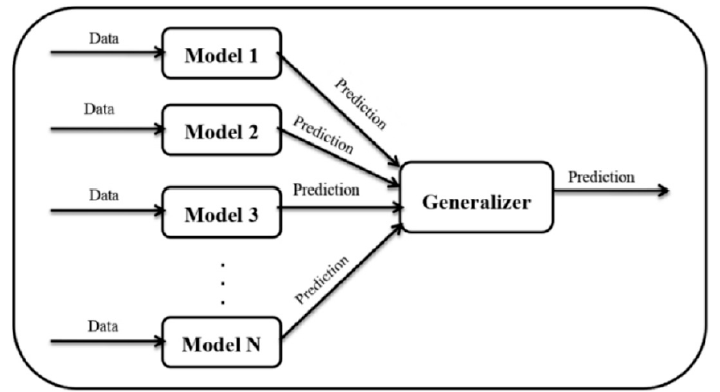
Figure 2. Scheme of ensemble classification.